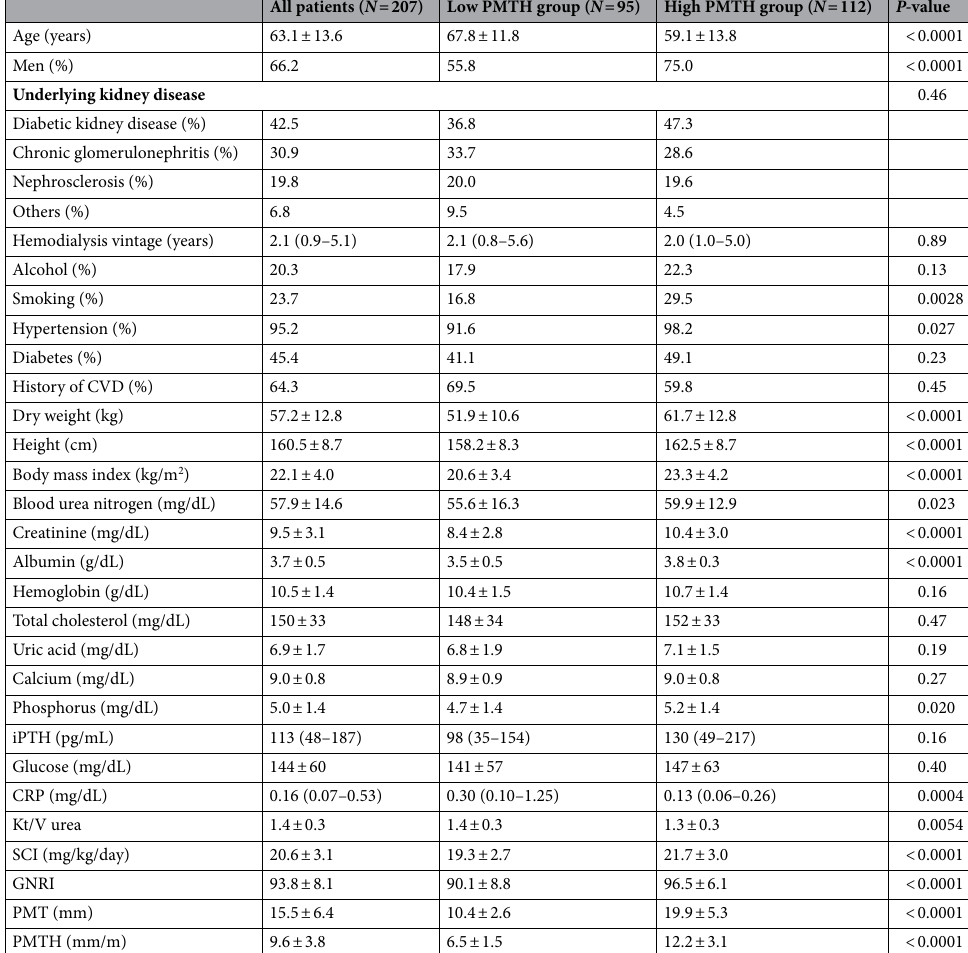
Table 1. Baseline characteristics of the study participants. PMTH psoas muscle thickness per height, CVD cardiovascular disease, iPTH intact parathyroid hormone, CRP C-reactive protein, SCI simplified creatinine index, GNRI geriatric nutritional risk index, PMT psoas muscle